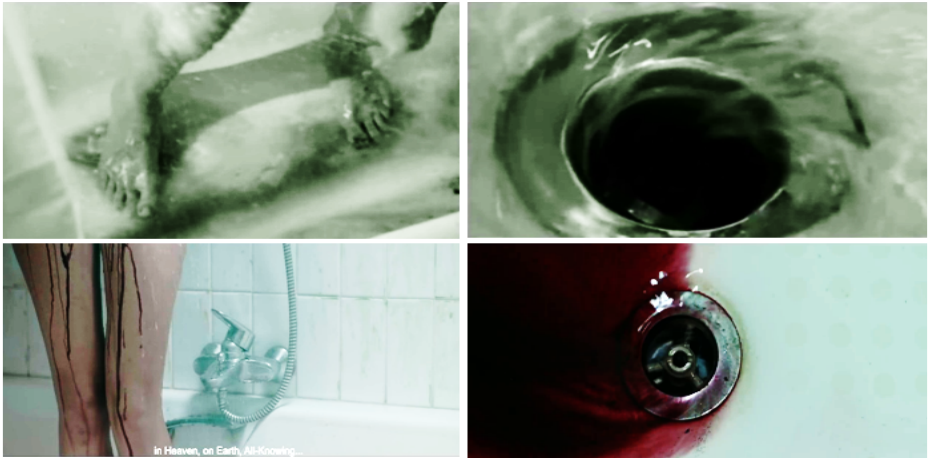
Figure 14: A tribute to Hitchcock based on his cult scene in